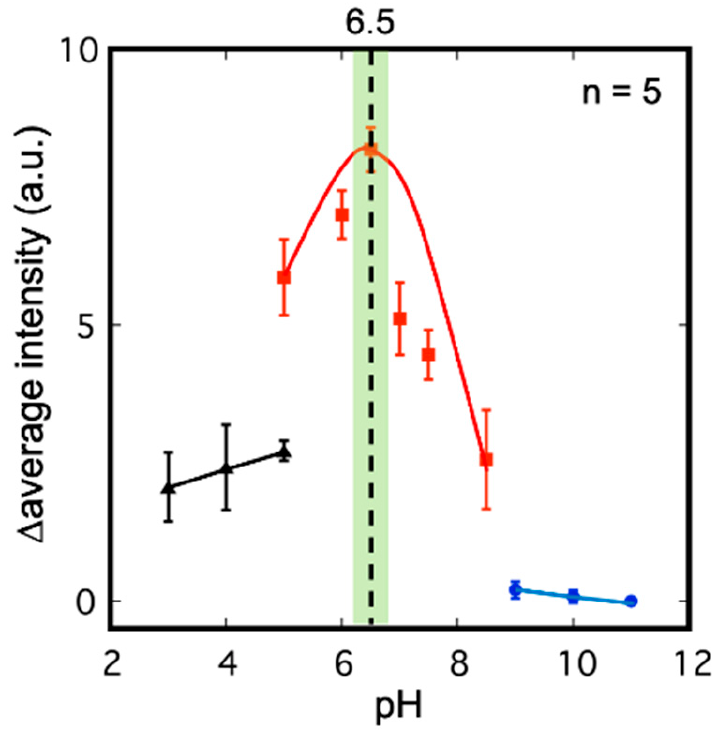
Figure 4. Evaluation of the pH dependence of fluorescence intensity in acetone gas imaging. ( ▲ (black): acetate 3.0, 4.0, 5.0; ■ (red): potassium phosphate 5.0, 6.0, 6.5, 7.0, 7.5, 8.5; ● (blue): carbonate bicarbonate 9.0, 10.0, 11.0).